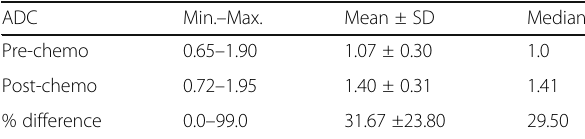
Table 2 Descriptive analysis of the studied cases according